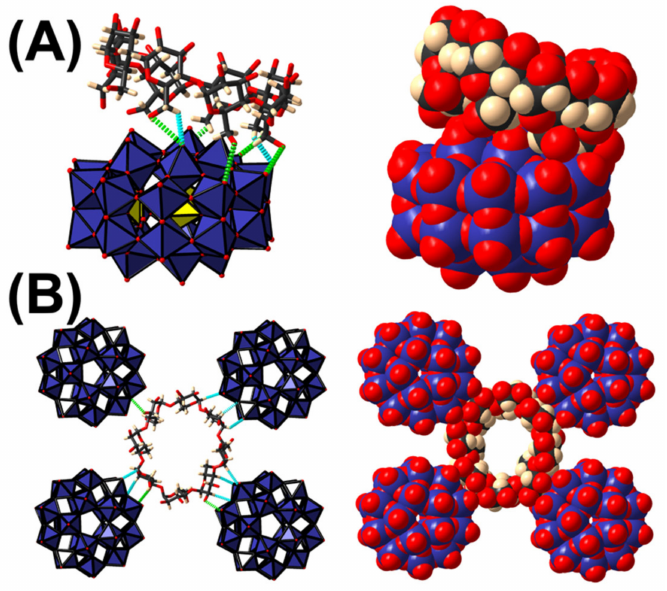
Figure 2. ( A ) Mixed representation of the supramolecular assembly observed in the solid-state involving γ -CD and the Preyssler anion [NaP 5 W 30 O 110 ] 14 − . ( B ) Mixed representation of the hybrid layer resulting from the interaction between the external surface of the organic macrocycle and the polyoxoanions. Hydrogen bonds (O-H ••• O-W) and short contacts (H ••• O-W) are represented in dashed green and blue lines,